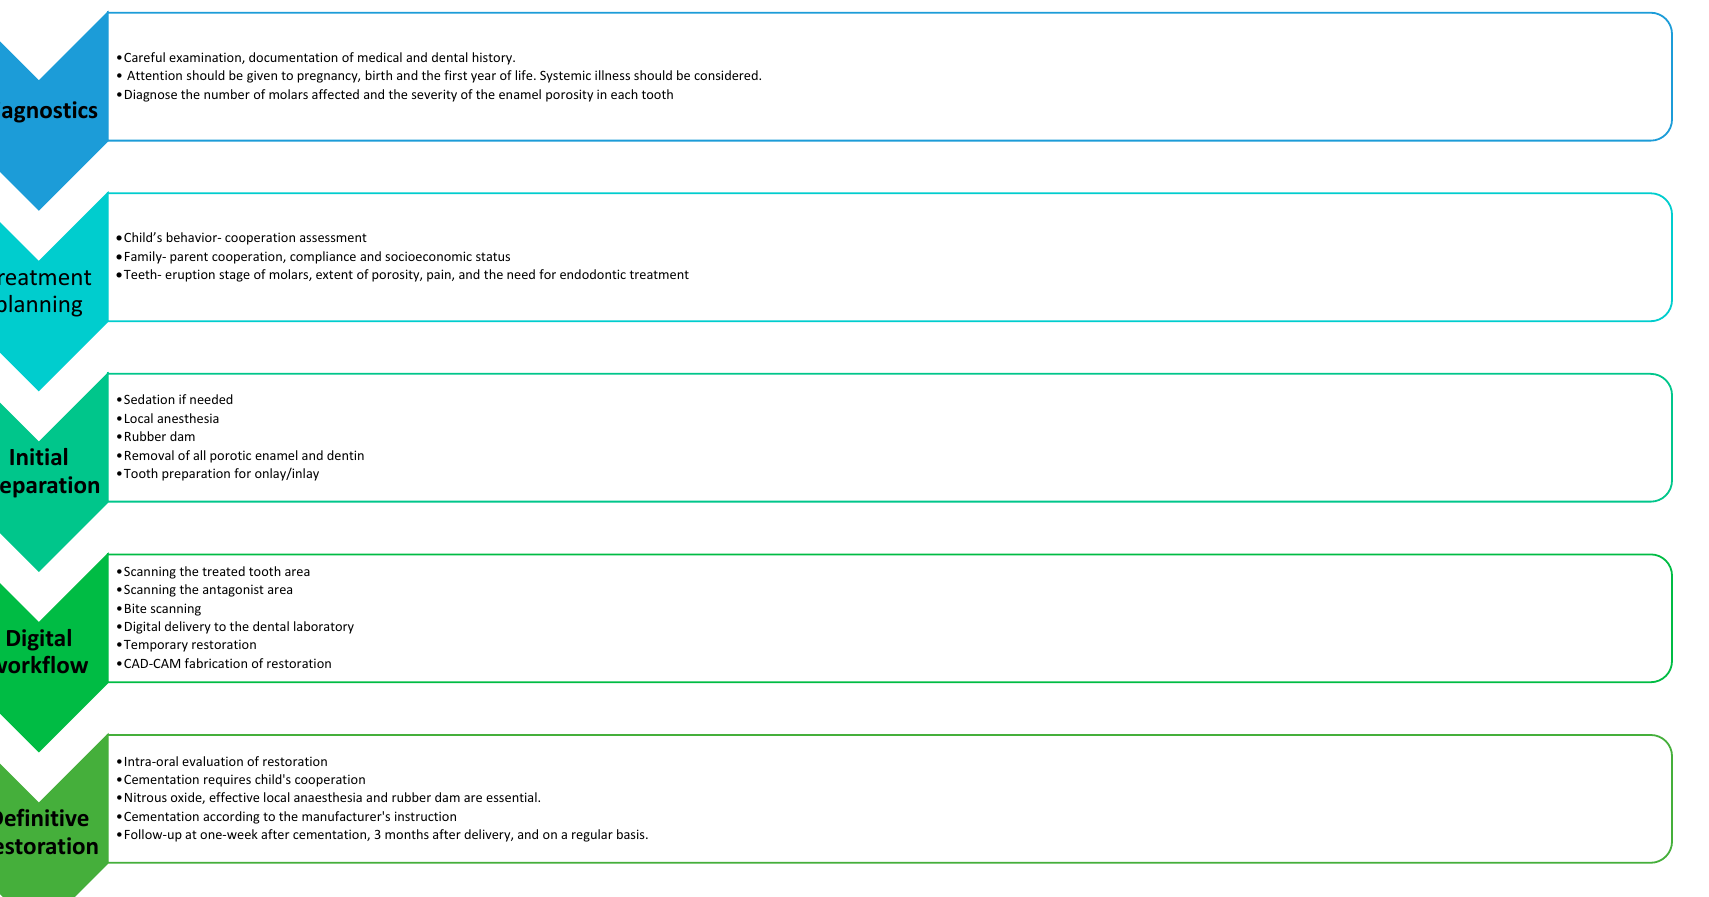
Figure 1. The suggested steps for the protocol of treatment approach in molar incisor hypomineralization molars in